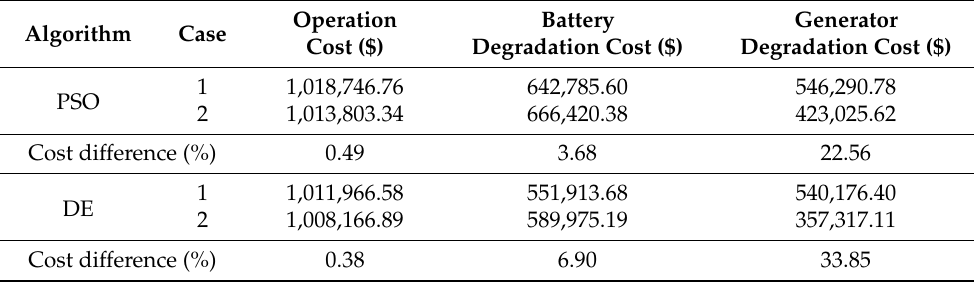
Table 5. The component of objective function after solving the optimal scheduling of ESS by the DE and PSO algorithms for case 1 and case